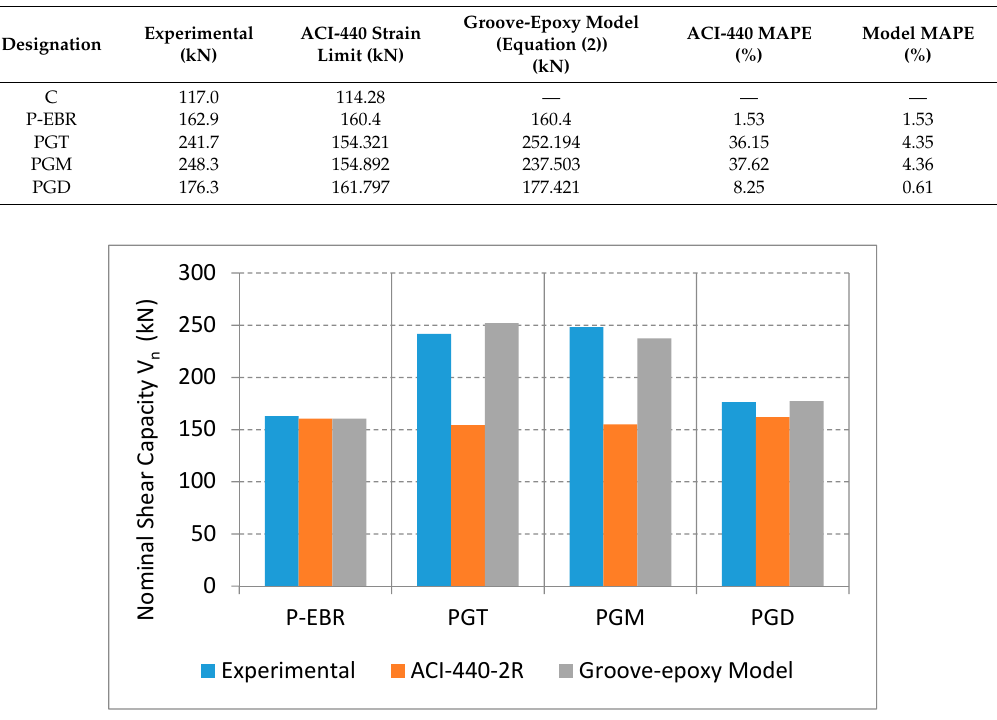
Figure 15. Comparison of measured and predicted shear capacity for RC beams strengthened with CFRP plates on groove-epoxy.